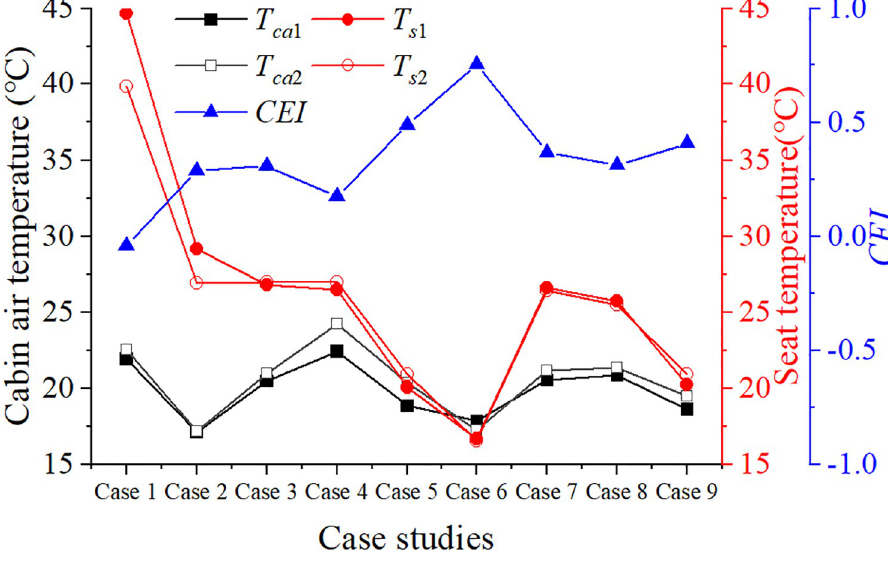
Fig 15. The pre-conditioning results for case study. All case studies achieve a CEI rating of 0 or higher, bringing cabin heat down to an acceptable value.